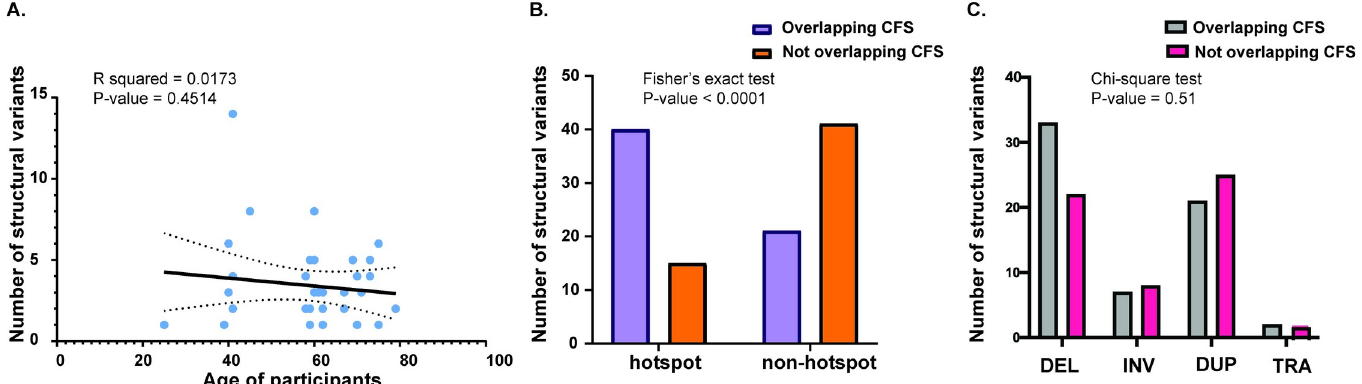
Fig 5. The structural variants identified in the genomes of skin cells. (A) The number of structural variants in each donor plotted against the ages of the donors. The black inclined line denotes the linear regression of the data, while the dotted curves denote the 95% confidence intervals. (B) The number of structural variants that were or were not within hotspots and common fragile sites. A Fisher’s exact test was performed to determine if structural variants in hotspots were also preferentially present within common fragile sites. (C) The types of structural variants that overlap and do not overlap common fragile sites. A Chi-square test was performed to determine if the structural variant types within common fragile sites were different from those that did not overlap common fragile sites. The source data for this figure are in S11